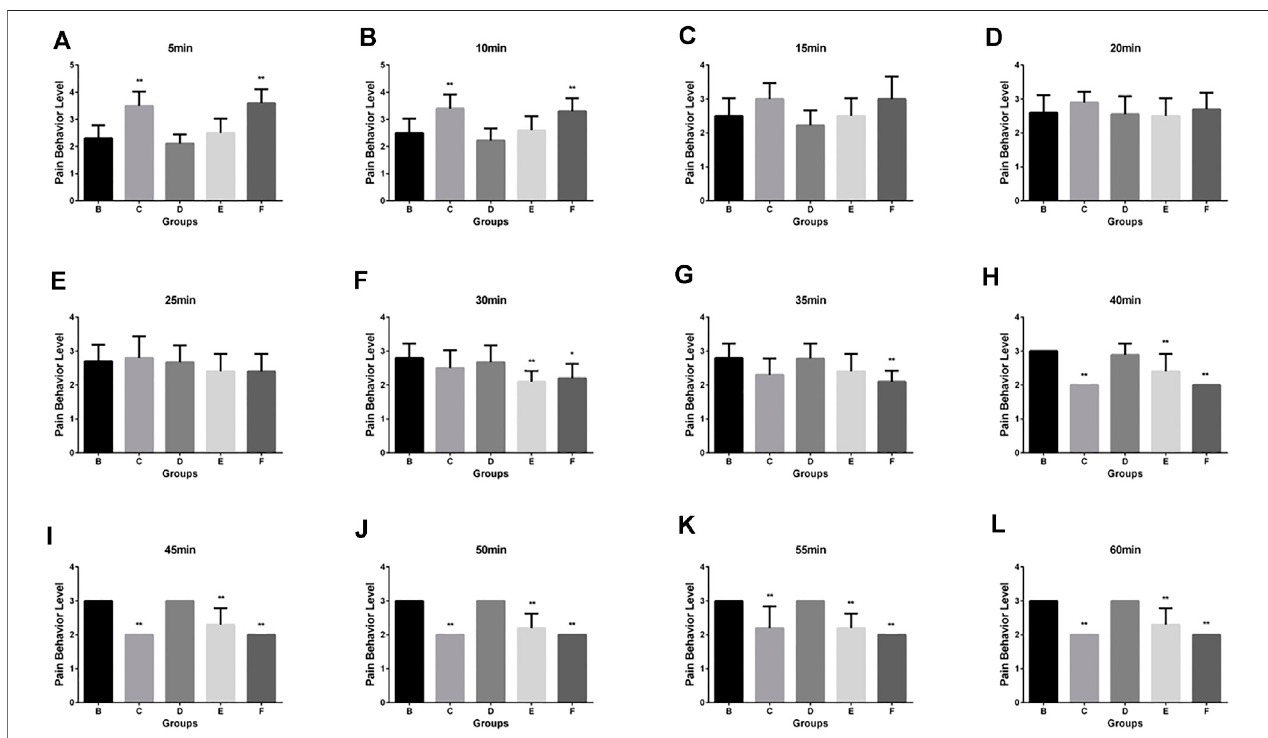
FIGURE3| Thepainbehaviorlevelbydifferentdeliverysystemindifferenttime. (A) Thepainbehaviorlevelbydifferentdeliverysystemin5 min; (B) in10 min; (C) in 15 min; (D) in 20 min; (E) in 25 min; (F) in 30 min; (G) in 35 min; (H) in 40 min; (I) in 45 min; (J) in 50 min; (K) in 55 min; (L) in 60 min.